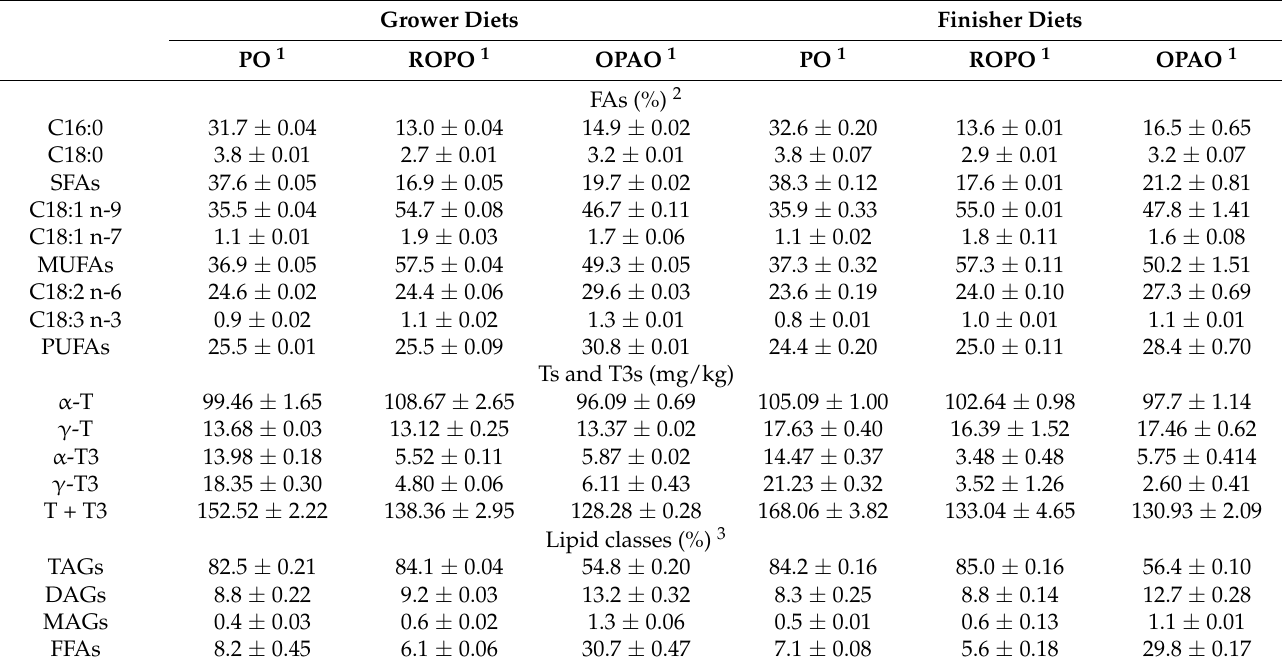
Table 3. Fatty acid, tocopherol and tocotrienol, and lipid class compositions of the grower and